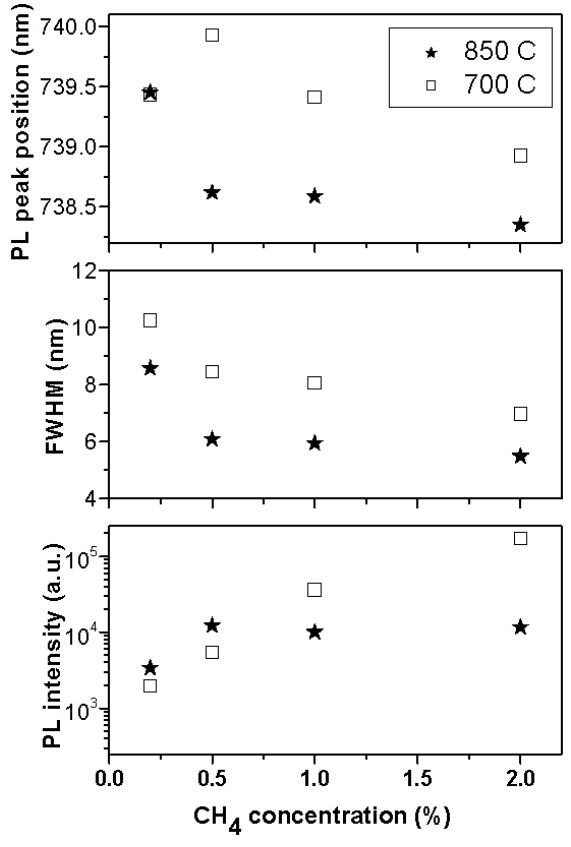
Figure 5: Evolution of SiV PL peak parameters with methane content of the feed gas in sample sets prepared at different substrate temperatures. The emission intensity is normalized to diamond Raman peak intensity obtained from the multicomponent fitting of the Raman